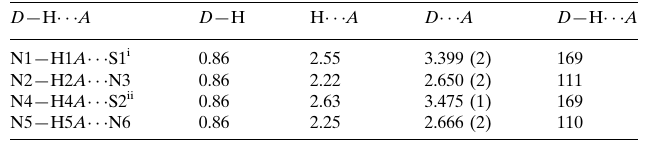
Hydrogen-bond geometry (A˚ , (cid:2)